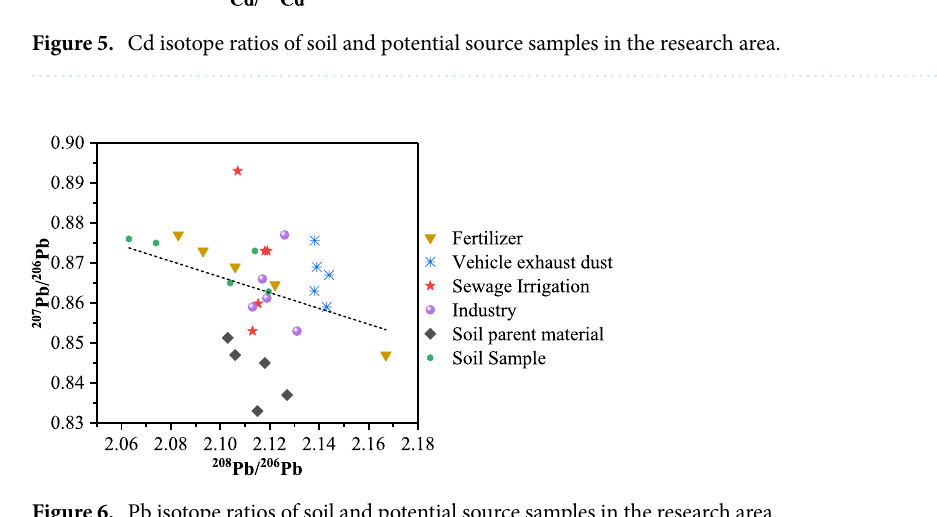
Figure 6. Pb isotope ratios of soil and potential source samples in the research